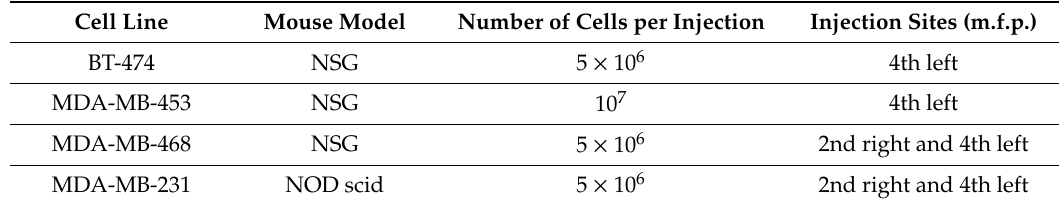
Table 1. Scheme of breast cancer cell line xenotransplantation in immunocompromised